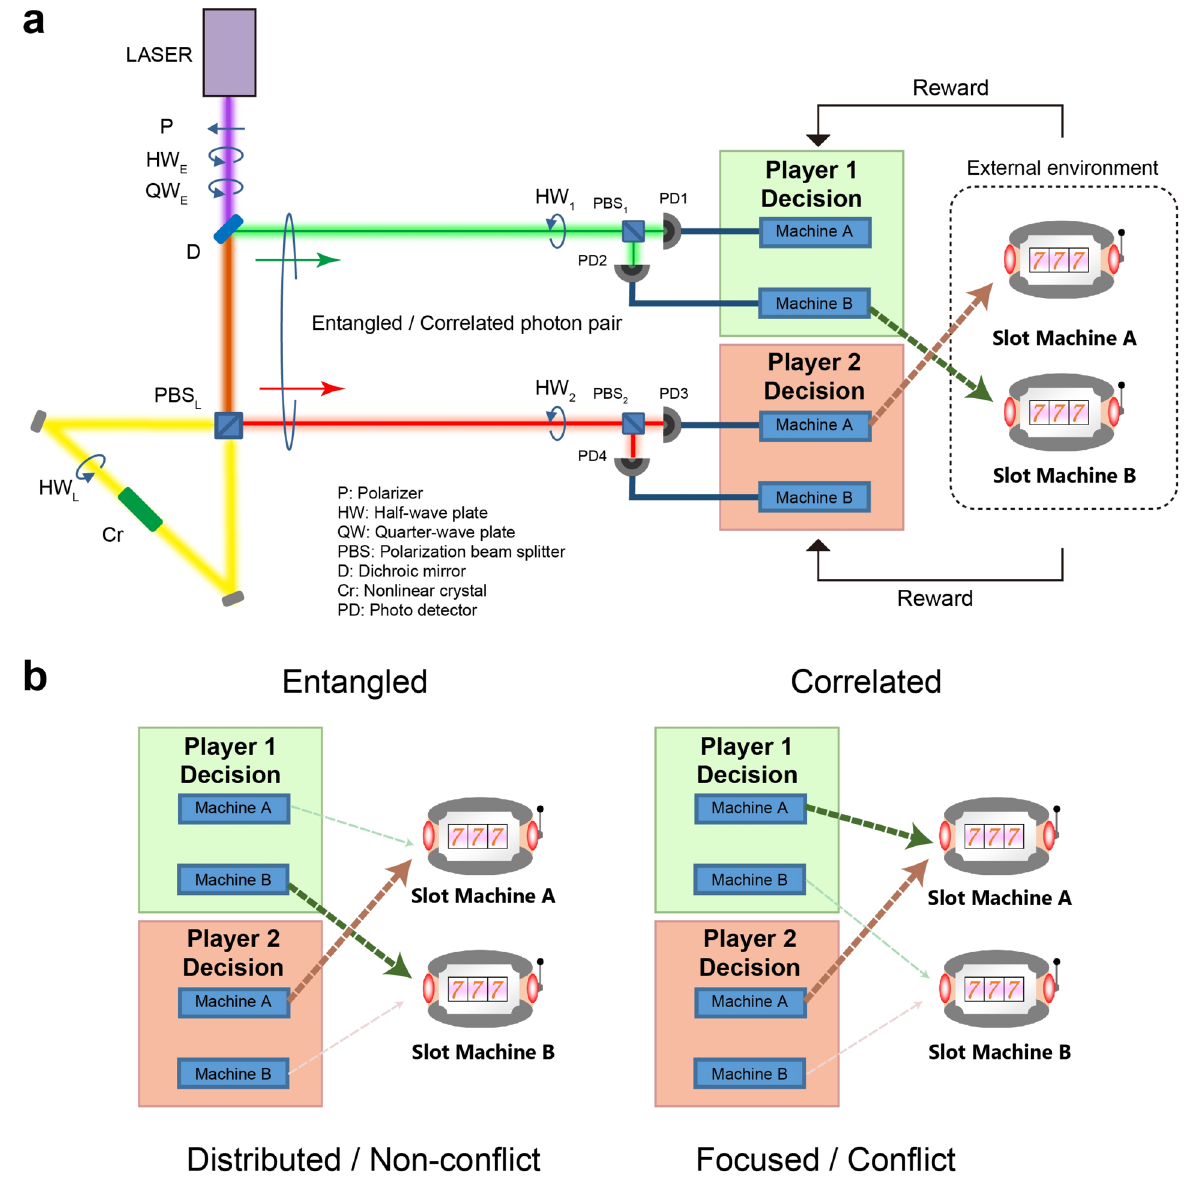
Figure 1. System architecture for entangled and correlated-photon mixed strategy for collective decision making. ( a ) Schematic of the optical system configuration consisting of photon pair (either entangled or correlated) generation and photon detection systems that directly provide the decisions of the two players (Player 1 and 2) to select either of the two slot machines (Machine A or Machine B) in the external environment. ( b ) With entangled photons, the decisions of the players are never in conflict. With correlated photons, both players take the same decision by properly choosing the half waveplate angle (see text for details). The elements of ( a ) are adapted from Chauvet et al. 16 . Copyright 2019 Author(s), licensed under a Creative Commons Attribution 4.0